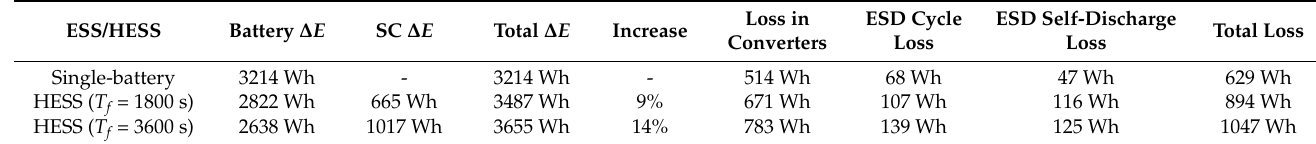
Table 2. Comparison of the Δ E and the losses of the ESDs with different time constants.